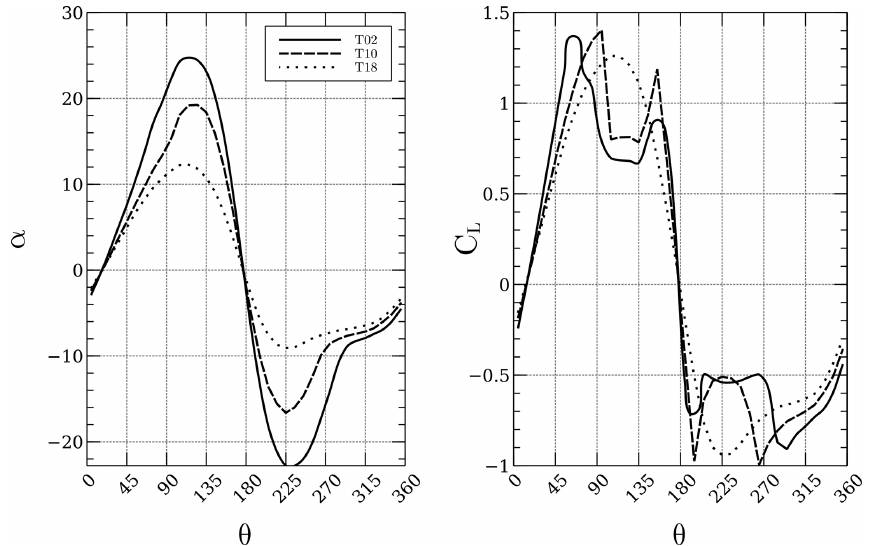
Figure 13. α and C L from turbines T02, T10 and T18.